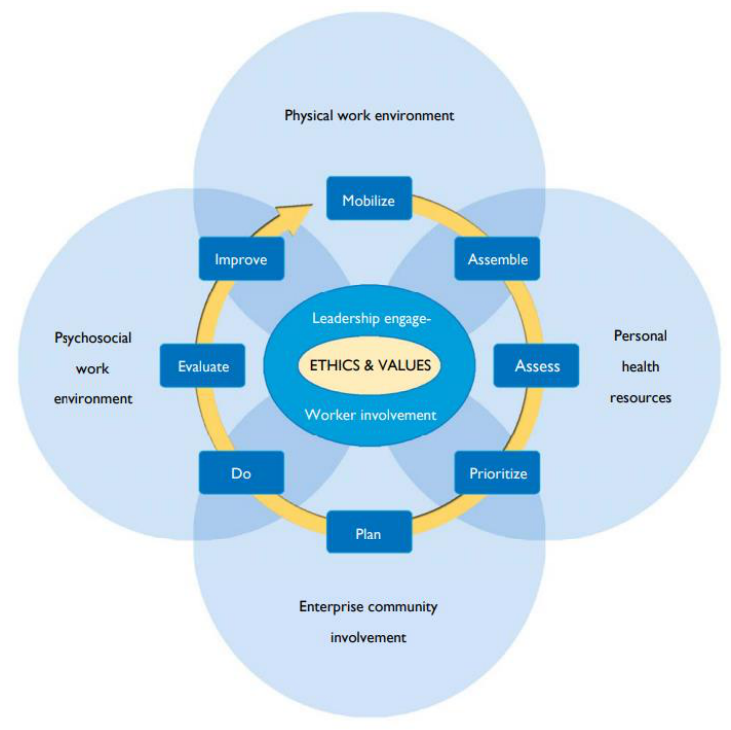
Figure 1. WHO Model of Healthy Workplaces: a model for action [66].